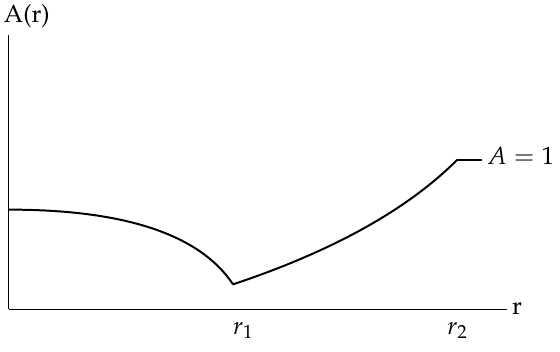
Figure 3. Solution A(r) with the input p(r) as in Figure